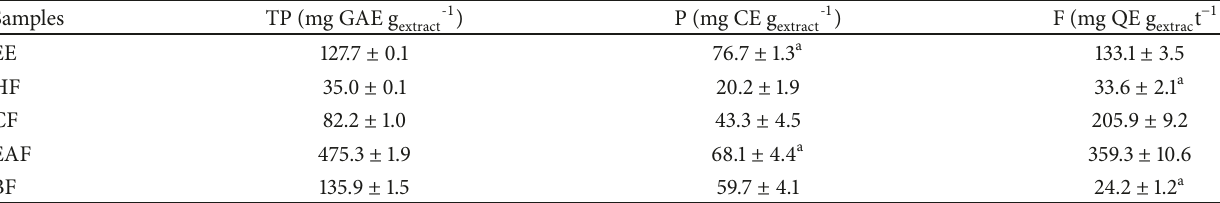
Table 1: Total phenolics, proanthocyanidins, and flavonoids for extracts and fractions of I. laurina leaves.